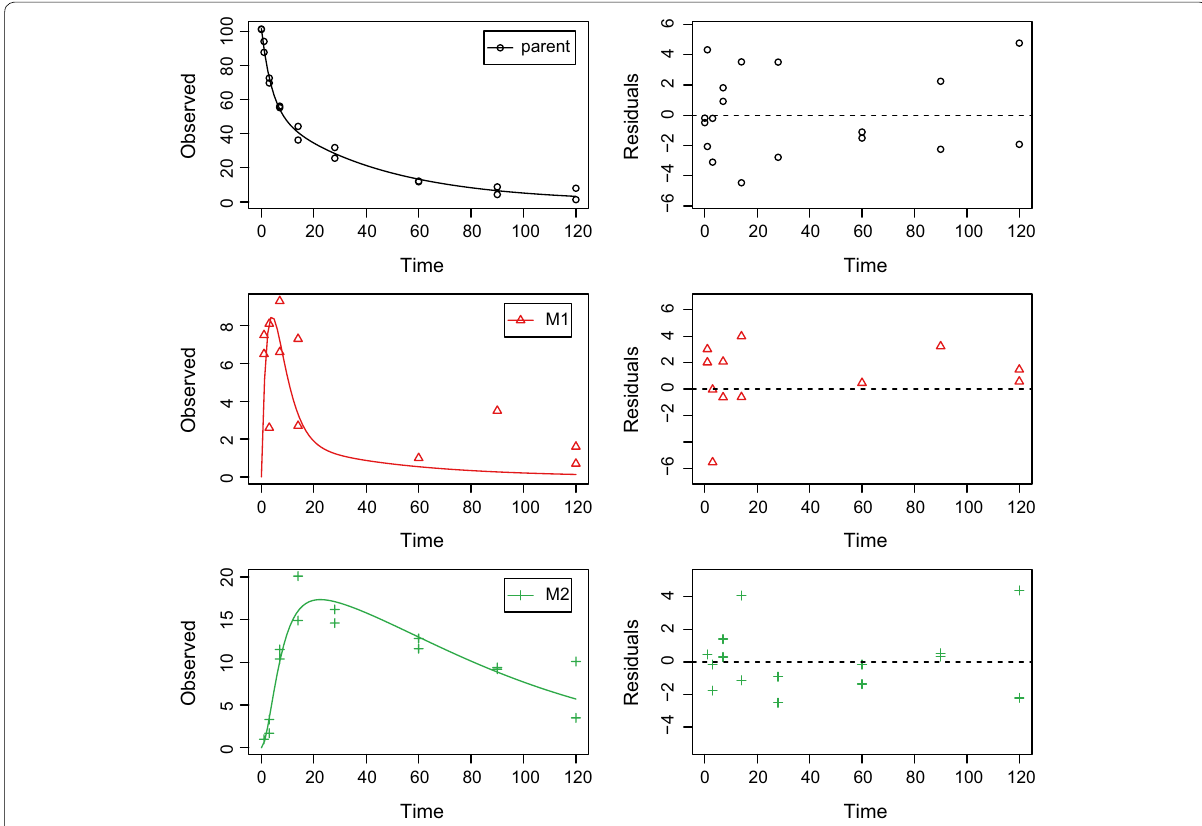
Fig. 1 Example plot of a fitted model with two transformation products The observed and fitted time course of the concentration of the different chemical compounds is shown in the left panels. The deviations between observed and fitted curve are shown in the right